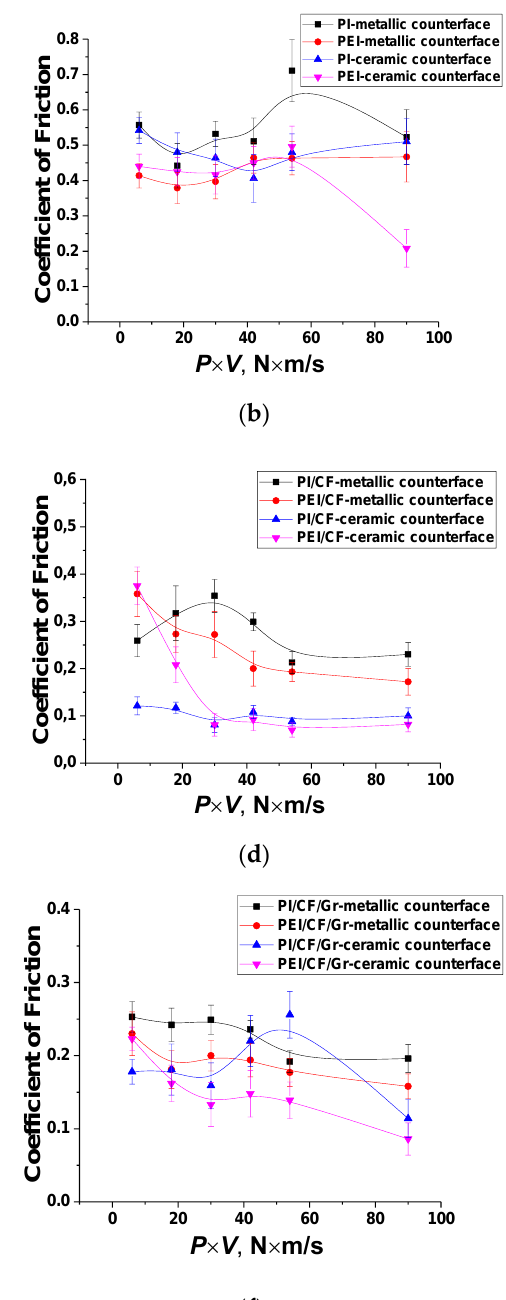
19 of 26 Table 7. A comparison of the tribological properties and the TL characters for the PI/10CCF/10Gr and PEI/10CCF/10Gr composites. Materials